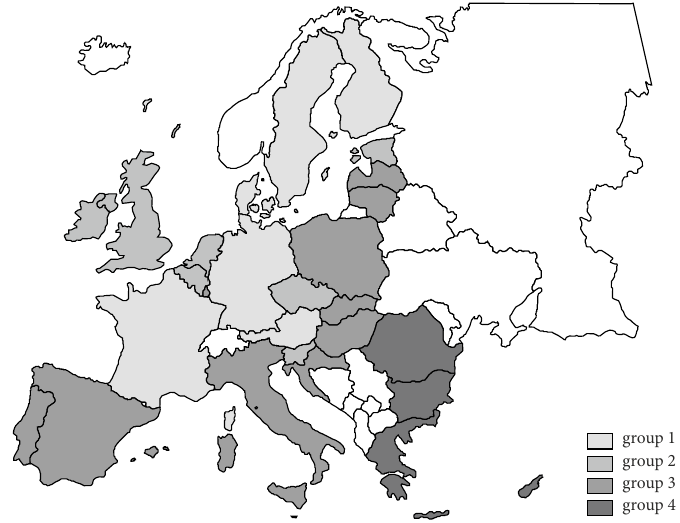
Figure 6. Spatial distribution of EU countries according to the SDG index in 2019 (source: own elaboration based on SDSN and IEEP, 2019, p. 3)